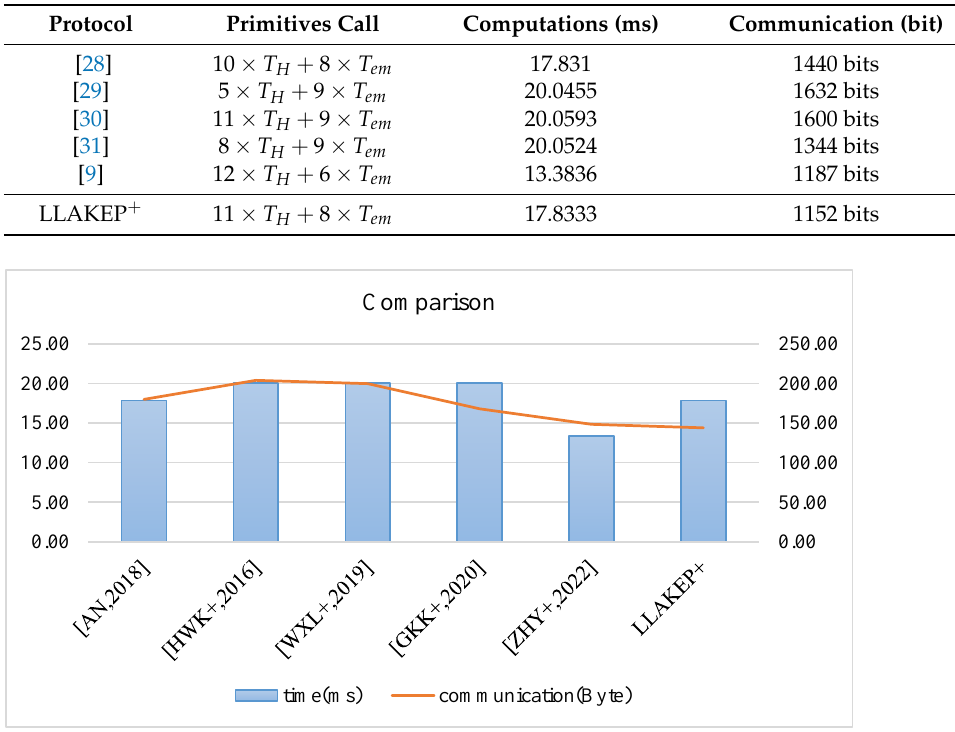
Figure 7. Comparison of LLAKEP + and related protocols ([AN,2018] [28], [HWK+,2016] [29], [WXL+,2019] [30], [GKK+,2020] [31], and [ZHY+,2022] [9]) in the term of computation and communi- cation cost, the cost of kdf considered equal to a call to hash